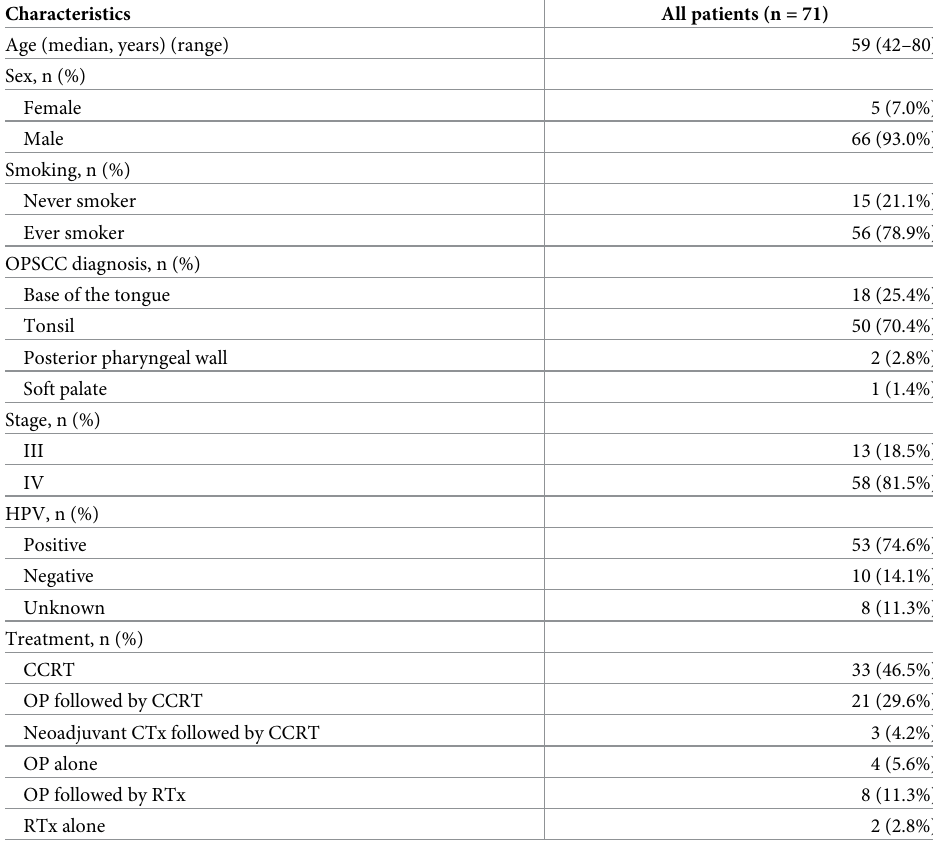
Table 1. Baseline characteristics of patients with oropharyngeal squamous cell